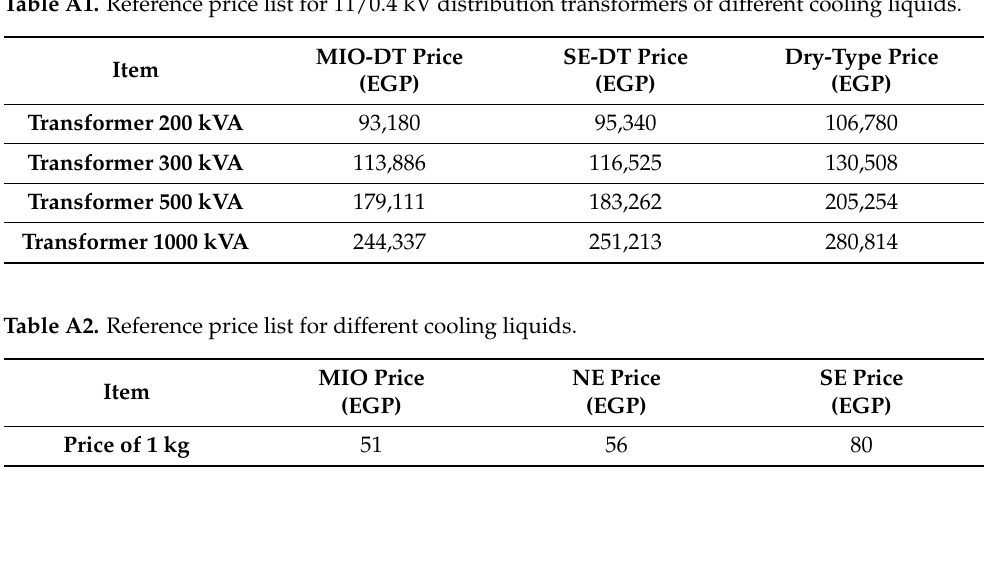
Table A1. Reference price list for 11/0.4 kV distribution transformers of different cooling liquids.